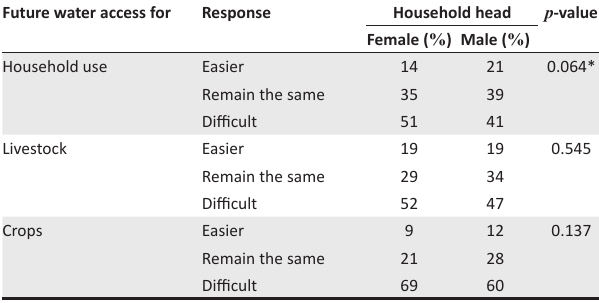
TABLE 4: Perception of future water